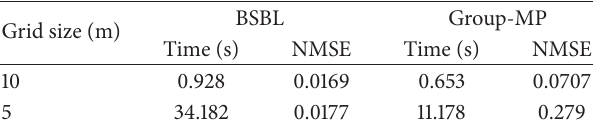
versus SNR in Figure 4. BSBL- ℓ 1 is applied with and without Table 1: Comparison of computational time and